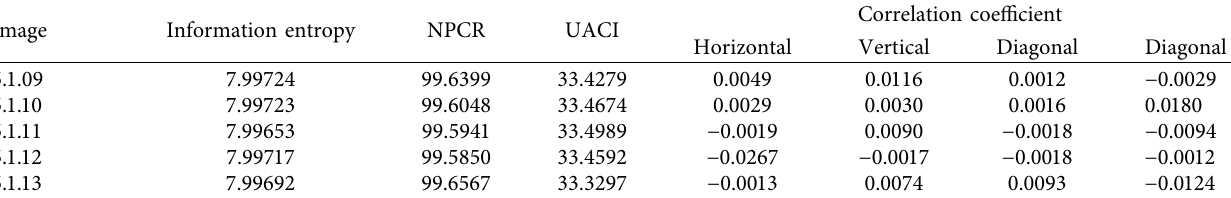
Table 14: Test images of USC-SIPI miscellaneous